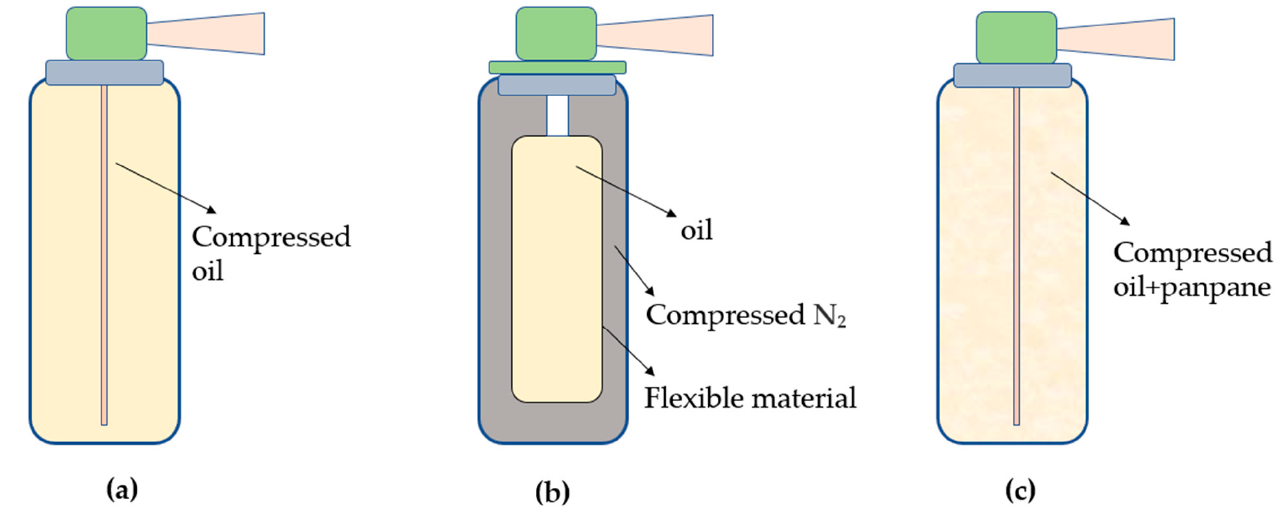
Figure 5. The schematic diagram of several spray oils: ( a ) is traditionally used to generate spray oil by compressing oil, ( b ) is used to form spray oil by compressing inert gas, and ( c ) is used to generate spray oil by compressing propane and oil together.